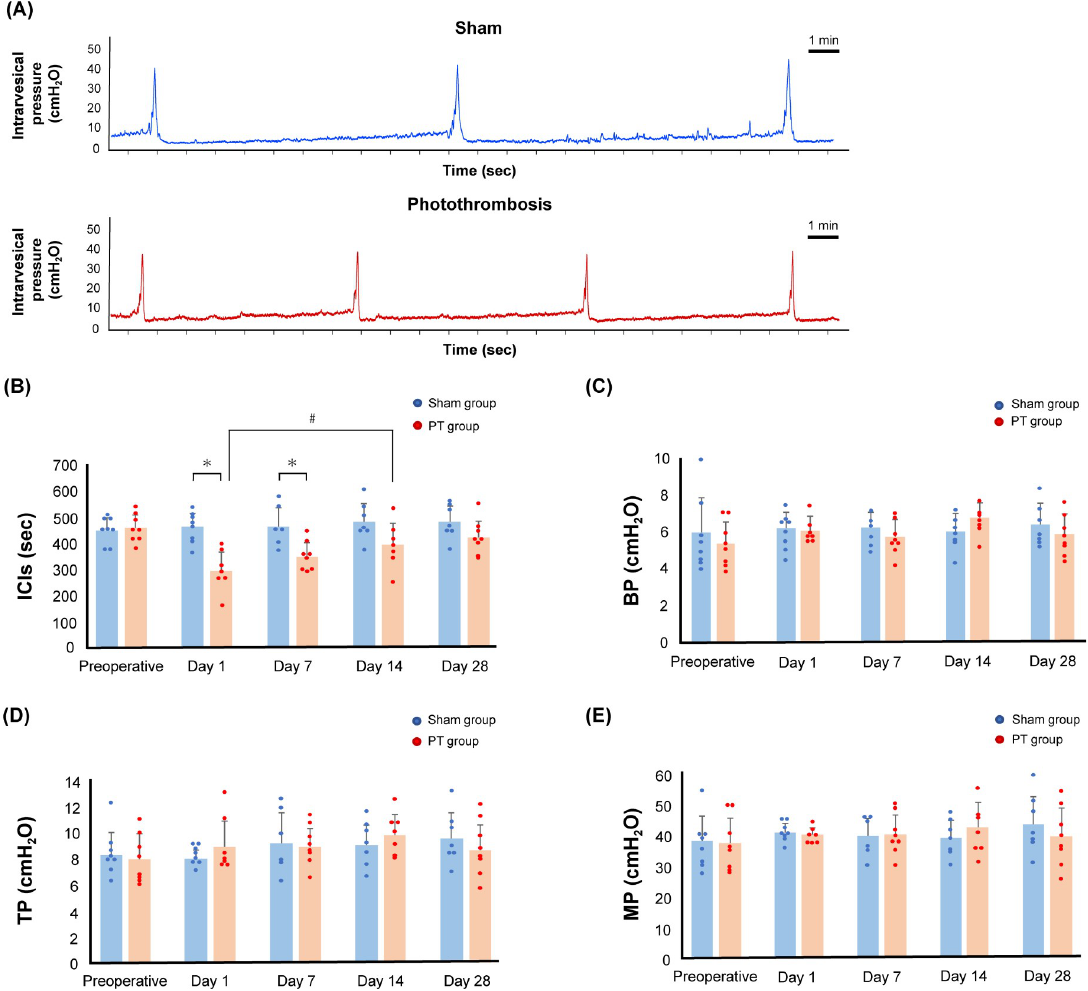
Fig 5. Cystometric study of the rats in the photothrombosis group compared with those in the sham group. A: The representative cystometric chart of each group on Day 1 after photothrombosis. B, C, D, and E: Time courses of the changes in intercontraction intervals (ICIs) (B), baseline pressure (BP) (C), micturition threshold pressure (TP, bladder pressure immediately prior to micturition) (D), and maximum intravesical pressure (MP) (E) of the rats in the sham group versus those in the photothrombosis (PT) group. Significant differences between ICIs in the sham and PT groups are indicated by # (P < 0.01, Student’s t-test). In the PT group, significant differences in the ICIs on Days 1 and 7 compared with the preoperative ICIs are indicated by �� (P < 0.01, two-way ANOVA followed by Tukey’s test for individual comparisons), and significant differences in ICIs on Days 14 and 28 compared with those on Day 1 are indicated by � (P < 0.05, two-way ANOVA followed by Tukey’s test for individual comparisons). Significant differences in the ICIs on Day 28 compared with those on Day 7 are indicated by � (P < 0.05, two-way ANOVA followed by Tukey’s test for individual comparisons). Values are represented in mean ±